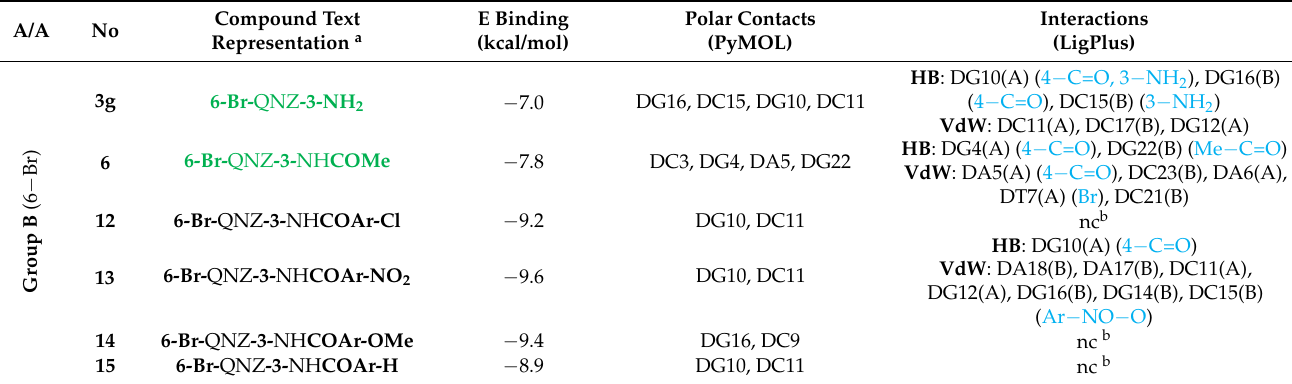
Table 2. Energy binding calculations towards DNA “in silico” of Group B.